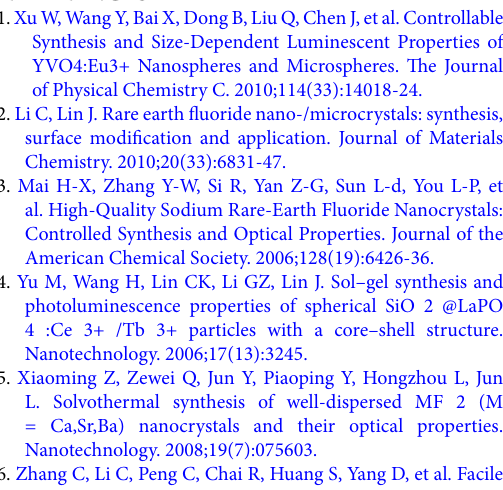
195 Nanochem Res 2(2): 188-197, Summer and Autumn